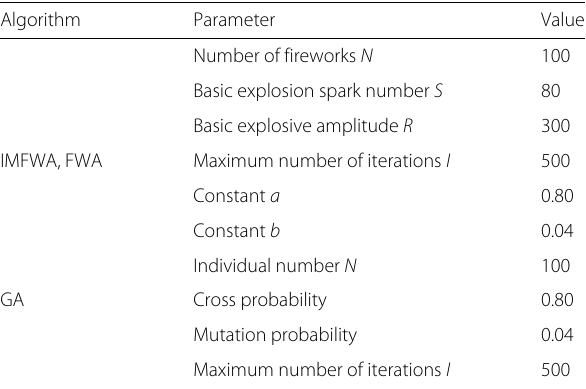
Table 1 Parameter settings of three